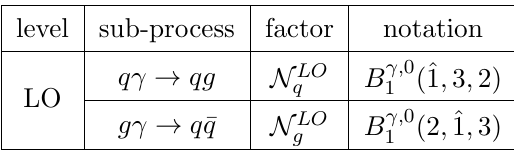
Table 1 . Summary of the scattering channels and matrix elements contributing at leading order. The argument with a caret denotes the initial-state parton, and the lepton momenta are omitted from the argument